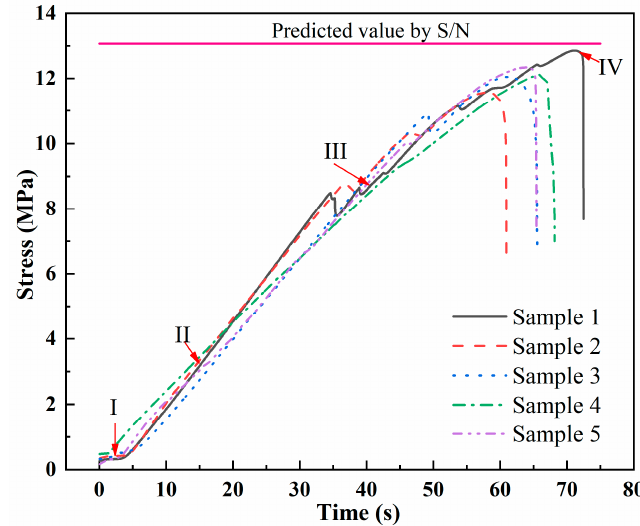
Figure 8. Time–stress relationship of GF/PP sample.